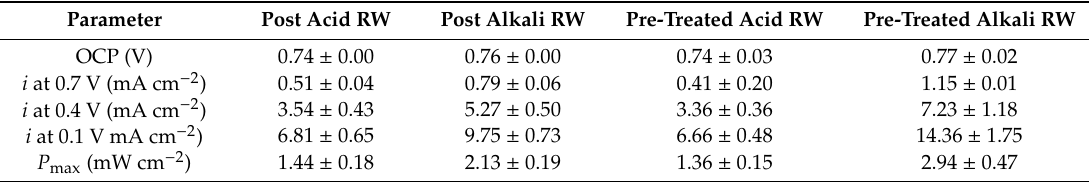
Figure 7. Polarization curve of chemical treated rubber wood derived biochar at pyrolysis temperature of 850 °C. Table 6. Electrochemical data for chemical treatment of rubber wood derived biochar at pyrolysis temperature of 850 °C.